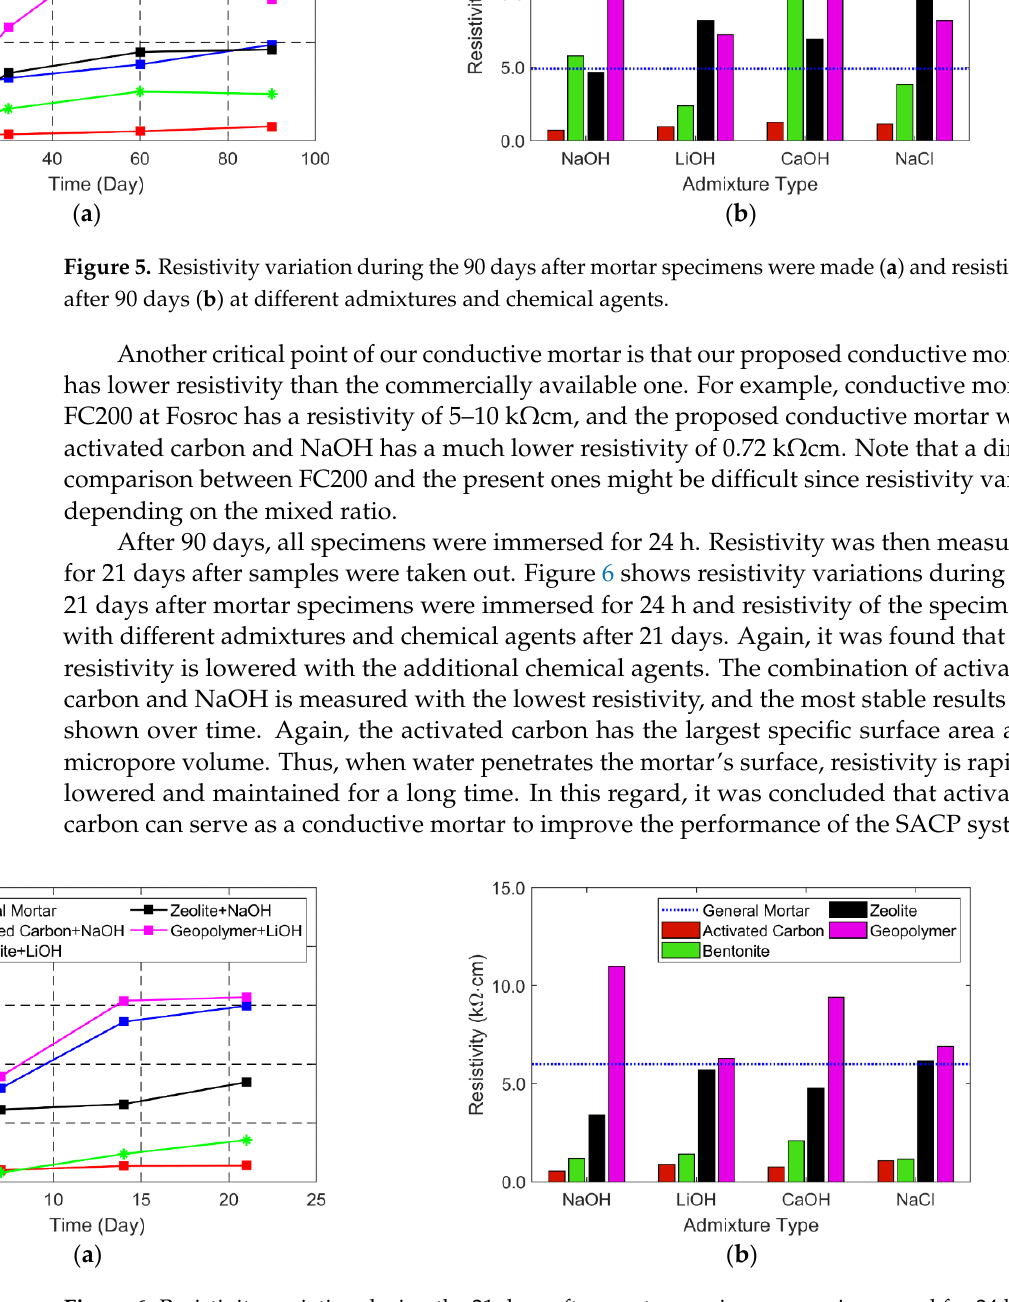
Figure 6. Resistivity variation during the 21 days after mortar specimens were immersed for 24 h ( a ) and resistivity after 21 days ( b ) at different admixtures and chemical